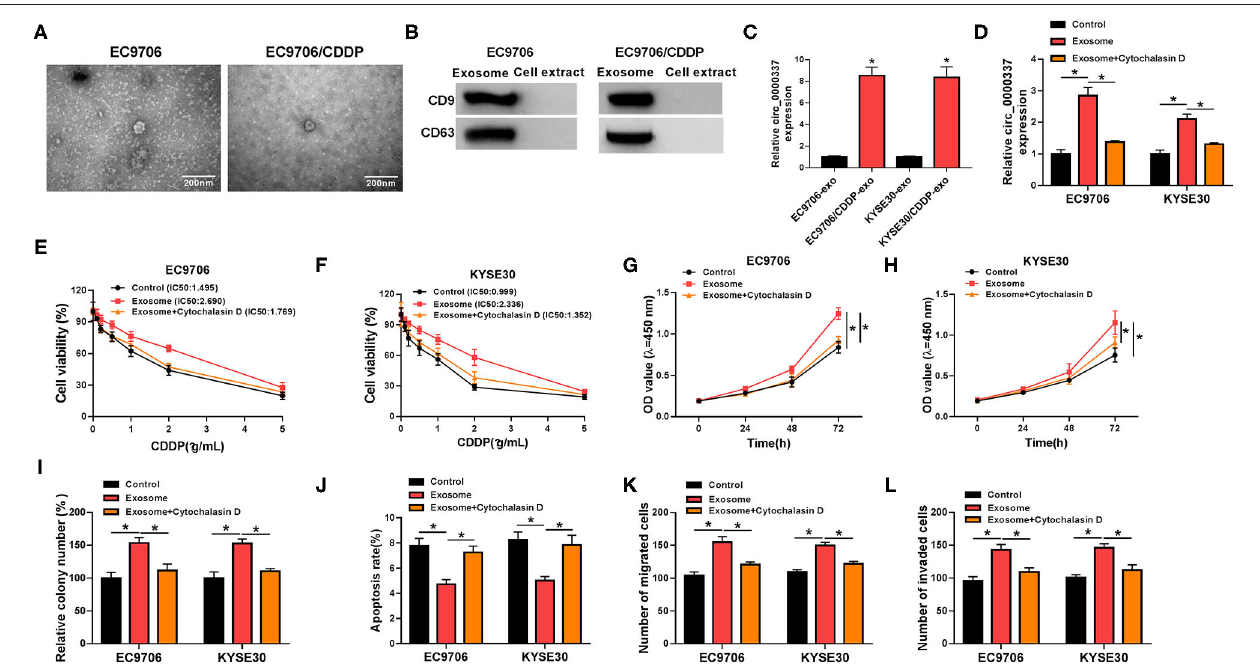
FIGURE 3 | Exosomal circ_0000337 enhanced CDDP resistance in esophageal cancer cells. (A) Exosomes extracted from the CDDP-resistant and parental esophageal cancer cells were analyzed by using a transmission electron microscope. (B) Western blot assay was applied to detect exosomal marker CD63 and CD9 expression. (C) Expression of circ_0000337 was examined in exosomes from EC9706, EC9706/CDDP, KYSE30, and KYSE30/CDDP cells. (D–L) EC9706 and KYSE30 cells were treated with control, exosome, and exosome + Cytochalasin D. (D) Circ_0000337 level was detected in treated EC9706 and KYSE30 cells. (E,F) Treated EC9706 and KYSE30 cells were challenged with CDDP at different concentrations for 48h, and cell viability was examined by CCK-8 assay. (G,H) Proliferation in treated EC9706 and KYSE30 cells was assessed by CCK-8 assay. (I,J) Colony number and apoptosis rate in treated EC9706 and KYSE30 cells were detected by colony formation and flow cytometry assays. (K,L) Migration and invasion in treated EC9706 and KYSE30 cells were examined by transwell assays. * P <